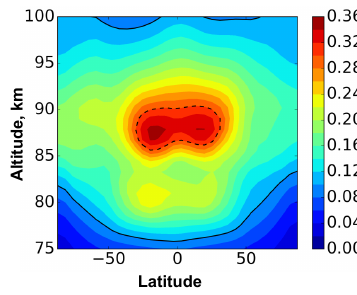
Figure 3. Daytime mean annually averaged R